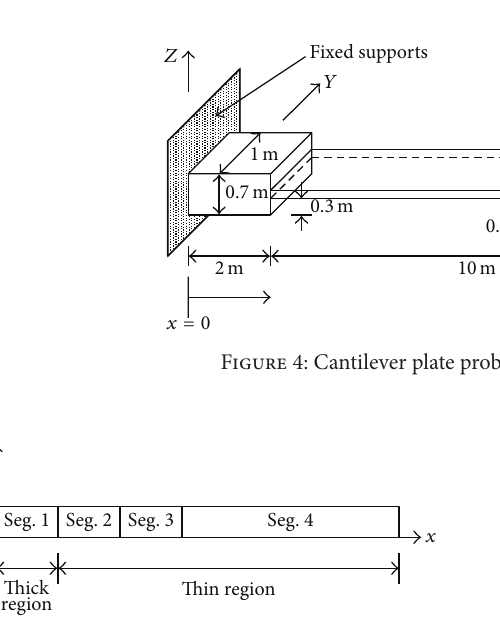
Figure 5: Partitioning the problem domain.